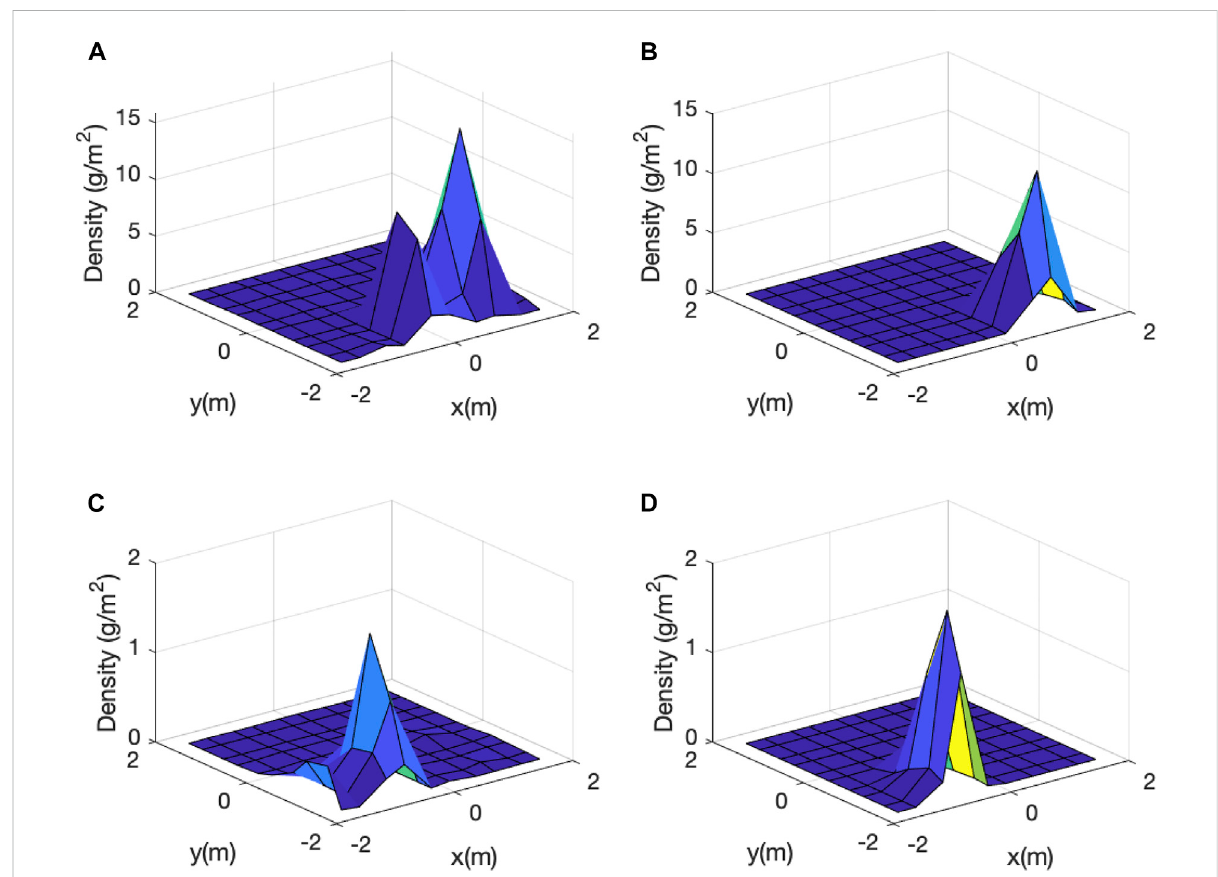
FIGURE 12 Modelperformance withrespect to thetest data: (A) : anexperimental/raw vermiculite distributionand (B) : its predicteddistributionbasedonour learned model (Eqn. 10); (C) : another experimental/raw vermiculite distribution and (D) : its predicted distribution based on our learned model (Eq. 10).